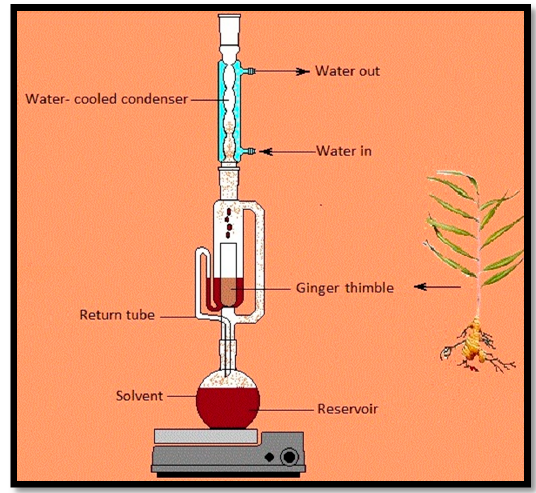
Figure 5. Soxhlet schematic.